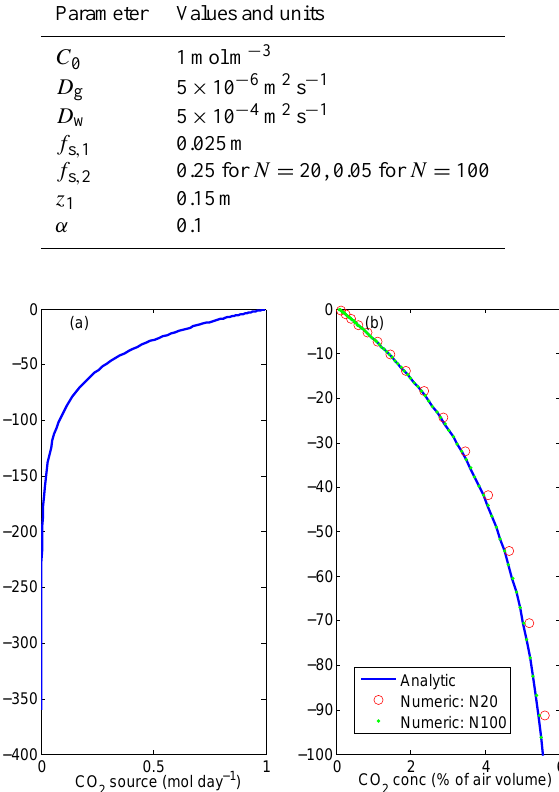
Table 4. Parameters used for the transient tracer diffusion model.